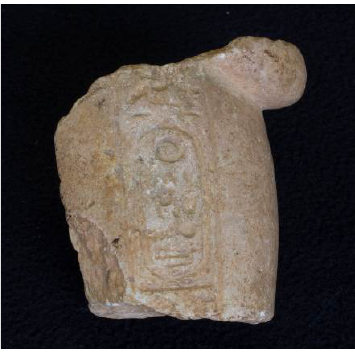
Figure 1. The fragment of the ushabty belonged to pharaoh Ahkenaten